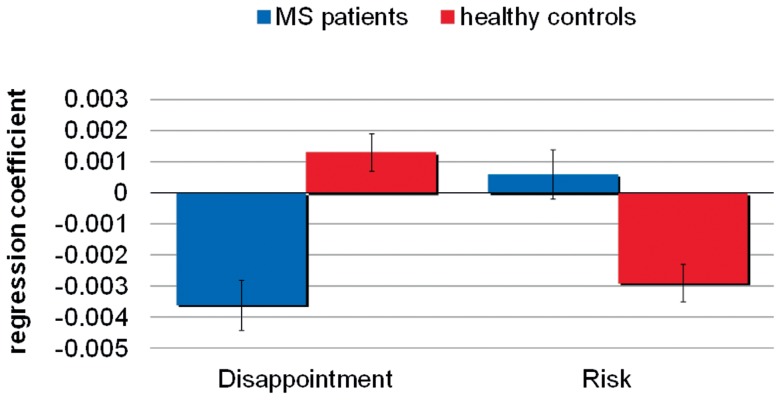
Model of choice integrating the effects of disappointment and risk in addition to the maximization of expected values.Negative coefficients reflect minimization of disappointment or risk. Model A integrates the effects of anticipating disappointment (d) in addition to the maximization of expected values (EV). MS patients did not minimize d. Model B integrates the effects of risk in addition to the maximization of expected values (e). Healthy controls were risk neutral while MS patients were risk averse.